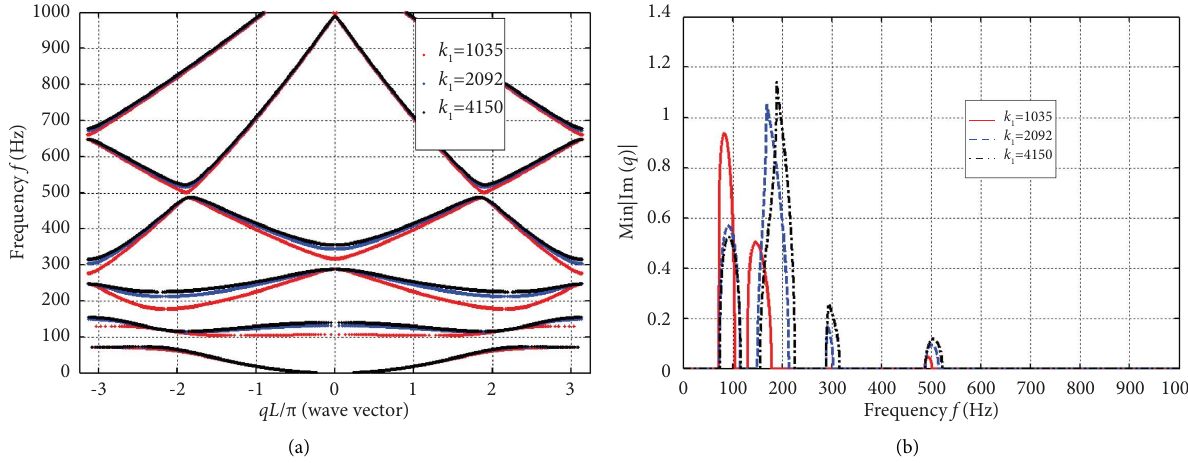
Figure 11: Efects of stifness on bandgap of the double-beam metamaterial: (a) efects of stifness on bandgap structures and (b) efects of stifness on attenuation constants.